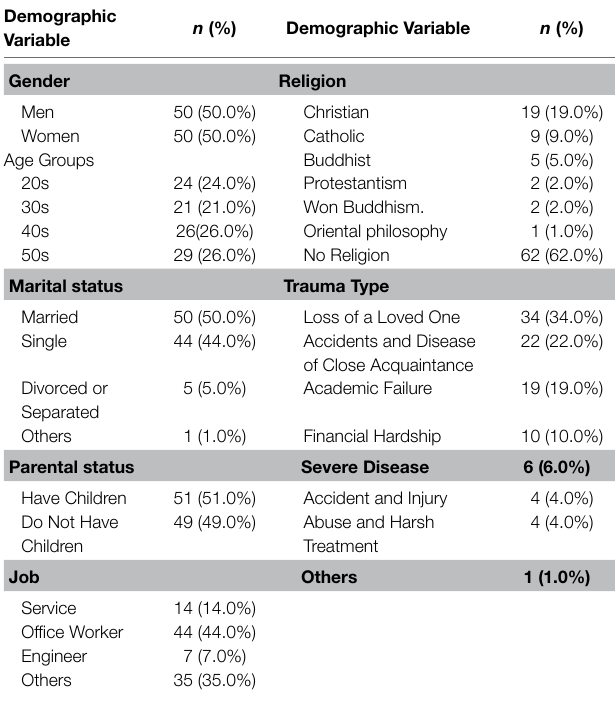
TABLE 1 | Demographic characteristics of Korean participants ( n =